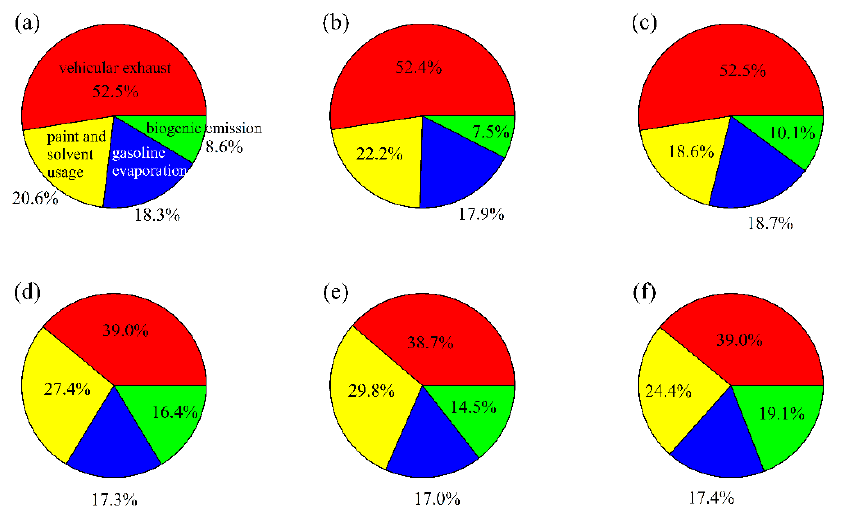
Figure 9. Relative contributions of 4 sources to total mass concentrations and ozone formation potential (OFP) of 19 NMHC species. ( a ) NMHCs mass concentrations for 1 May–31 July, ( b ) 1 May–15 June, and ( c ) 16 June–31 July 2020, ( d ) OFP for 1 May–31 July, ( e ) 1 May–15 June, and ( f ) 16 June–31 July 2020. The red, yellow, blue, and green colors mean that vehicular exhaust, paint and solvent usage, gasoline evaporation, and biogenic emission.